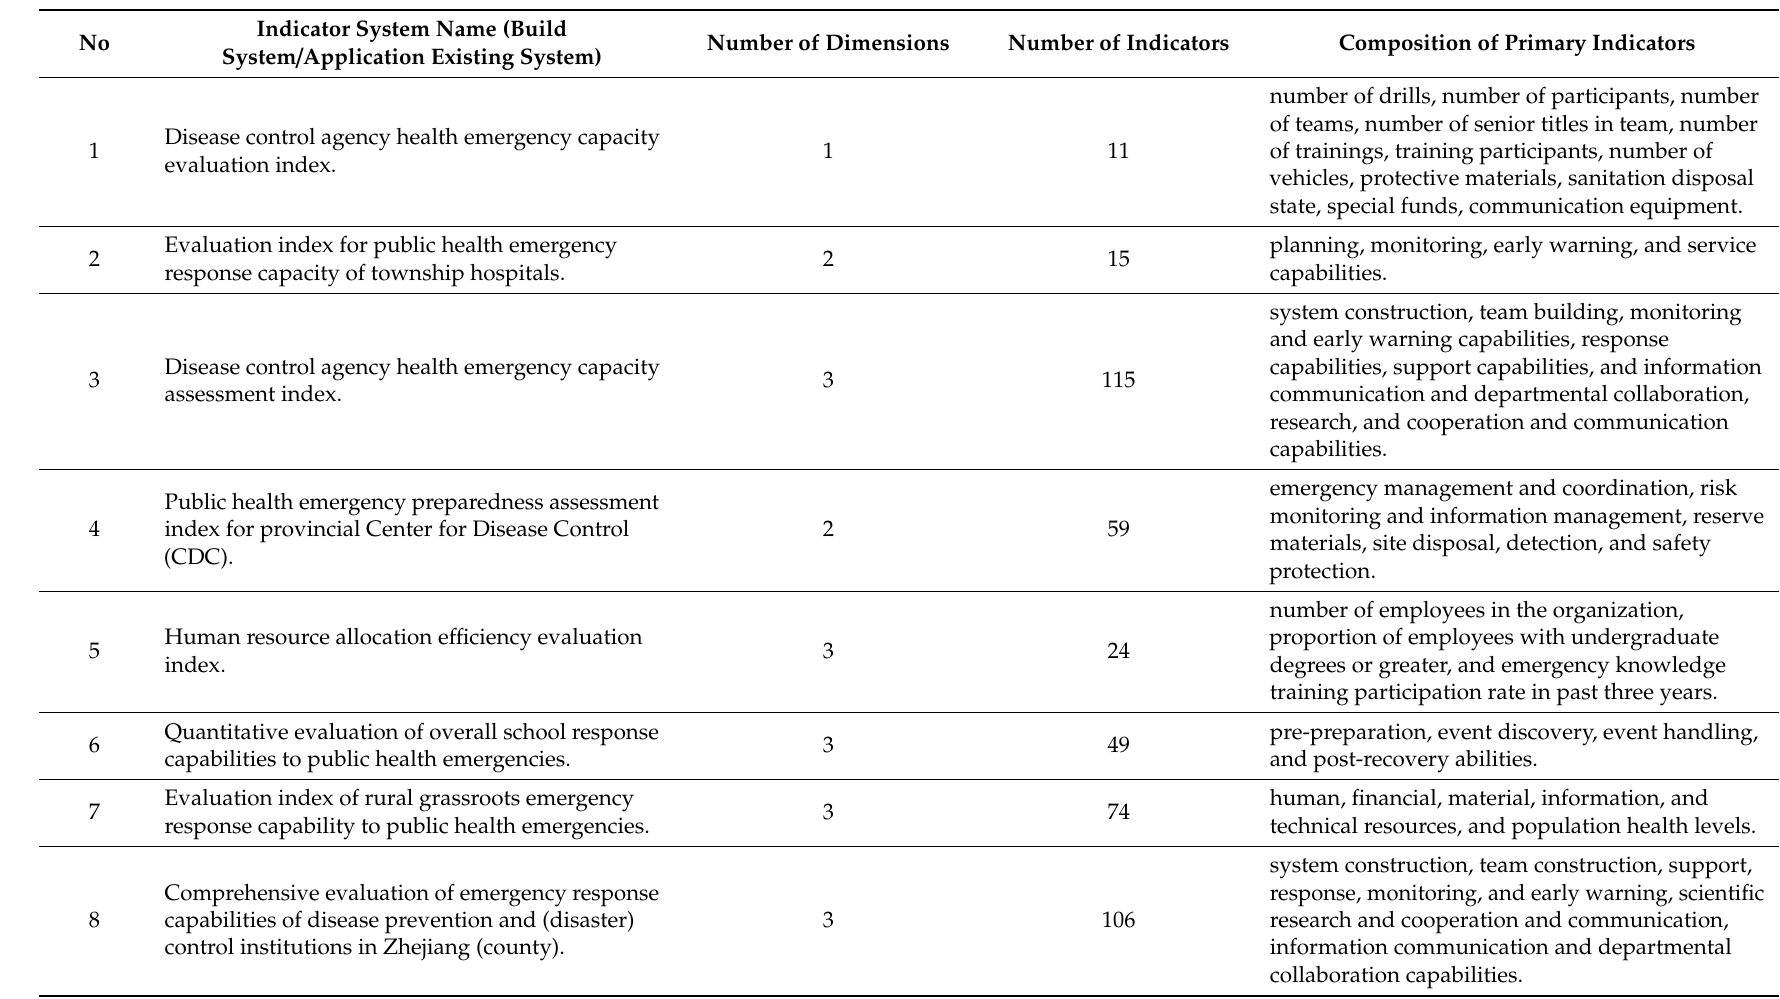
Table 3. Dimensional characteristics of evaluation system